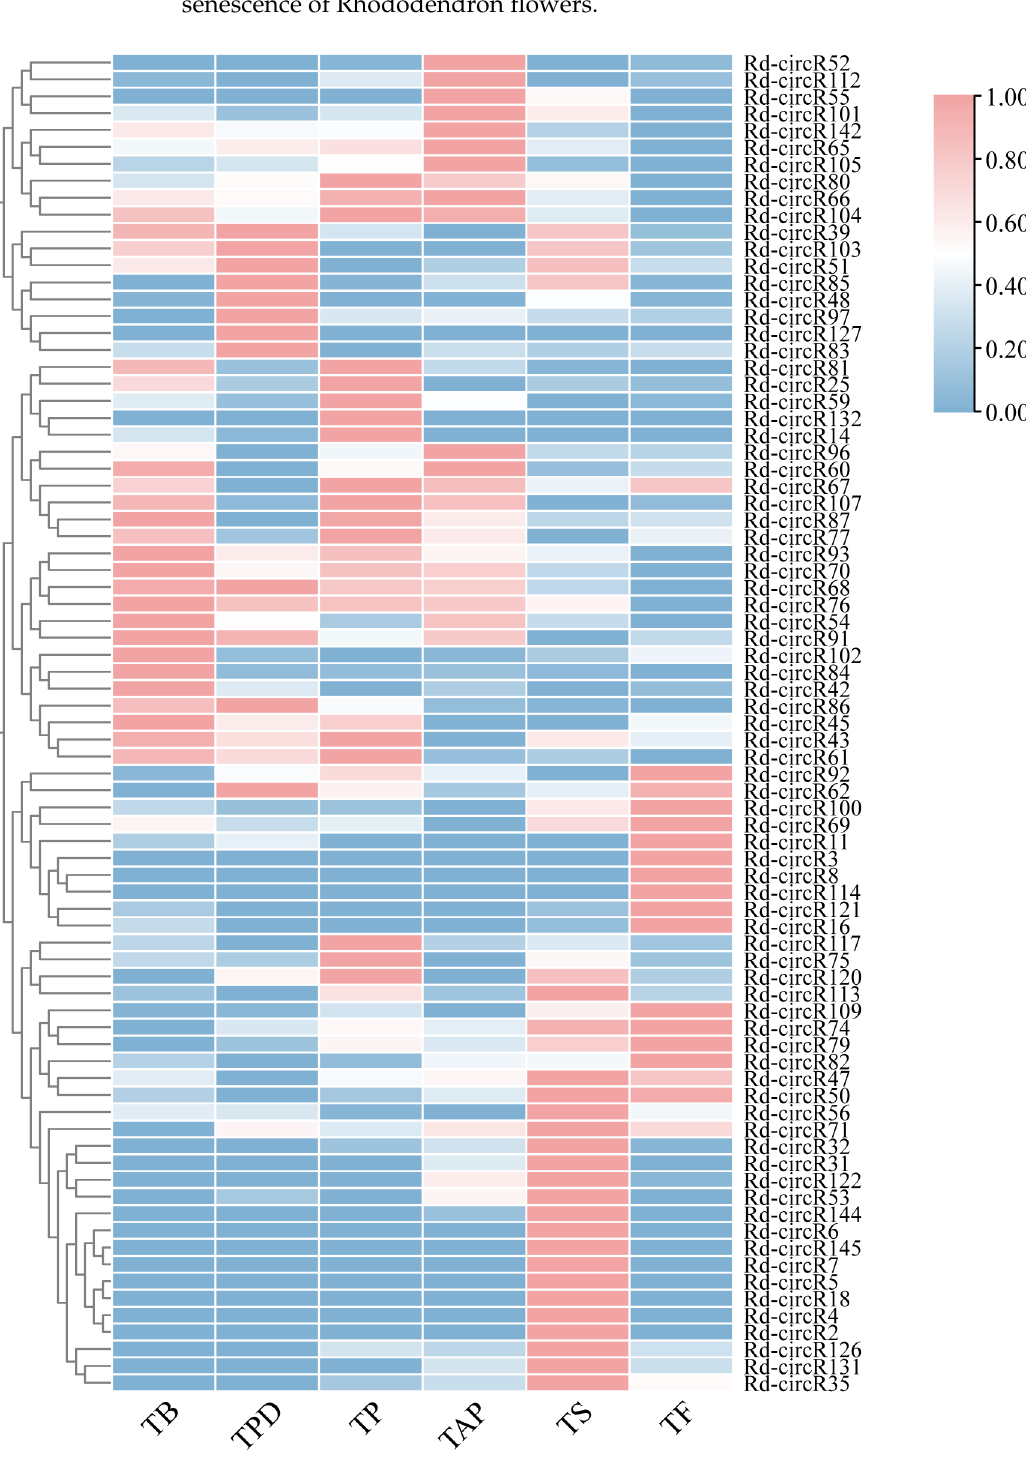
Figure 3. Heatmap showing the expression patterns of 79 DE-circRNAs during the lifespan of flow- ers. TB: the time of bud stage; TPD: pollen dehiscence stage; TP: pollination stage; TAP: after pollina- tion stage; TS: senescence stage; and TF: fading